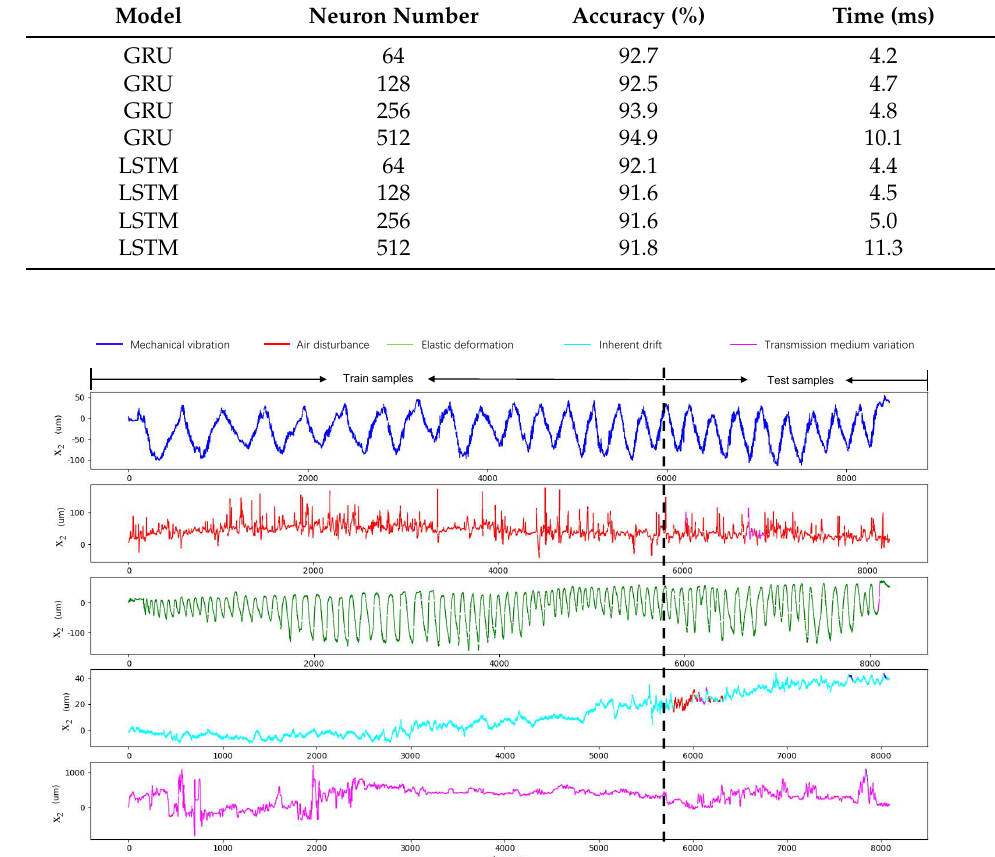
Table 1. Accuracy and training time of the model.